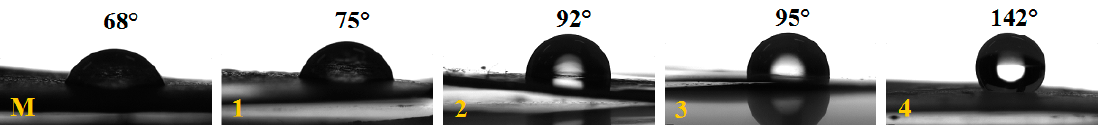
Figure 8. Profiles of water droplets deposited onto metallic substrate, covered with unfunctionalized ZnO (M) and with ZnO nanoparticles modified with (1) GPTMS, (2) PhTES, (3) OTES, and (4) ODTES, respectively.